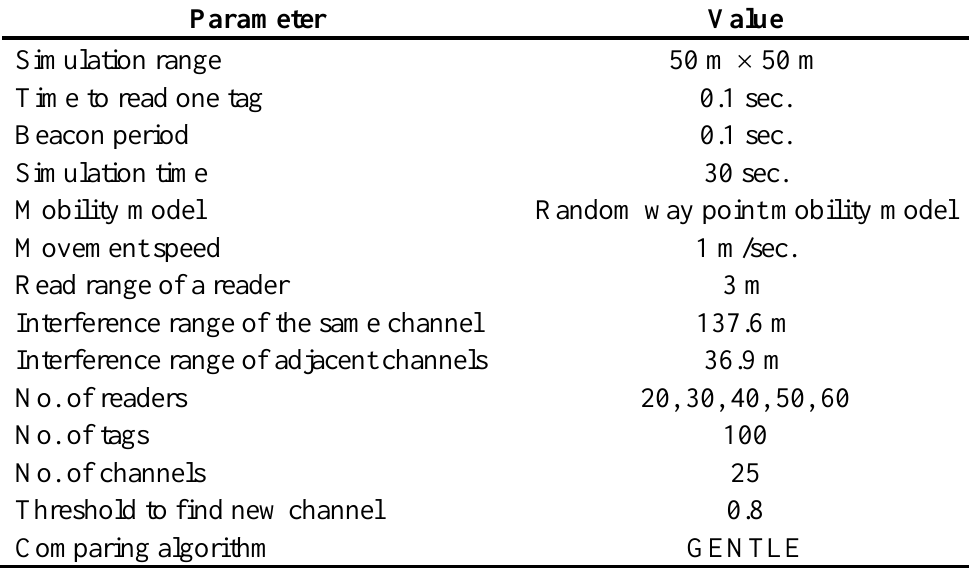
Table 6. Parameters for the